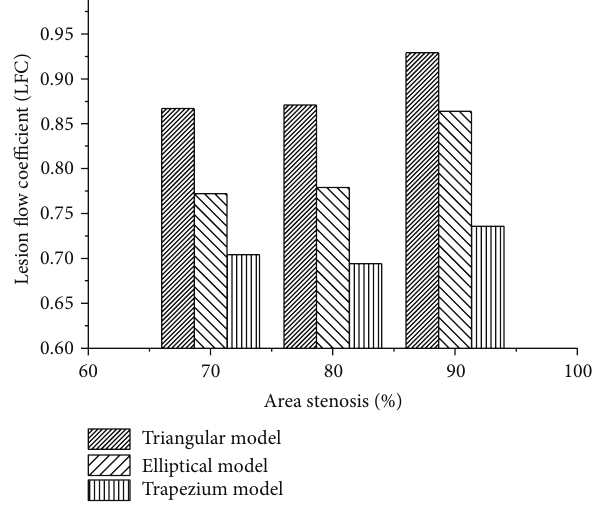
Figure 7: Variation of LFC with % AS in different shapes of models (triangular, elliptical, and